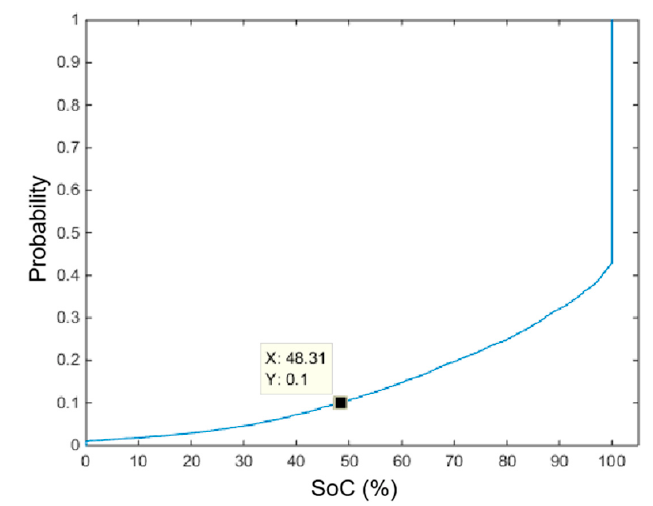
Figure 3. The cumulative density function (CDF) of the SoC.